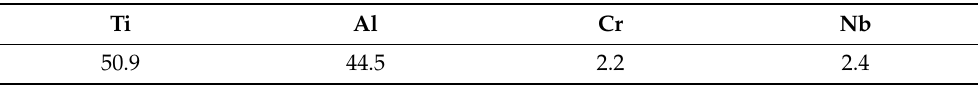
Figure 1. Light optical microscopy image of the microstructure of the investigated material after etching with Weck reagent (100 mL distilled water, 50 mL ethanol (96%), and 5 g ammonium- bifluorid [24]) using polarized light. Table 1. Chemical composition (at %) of the TiAl alloy, measured with an Agilent 5100 ICP-OES.